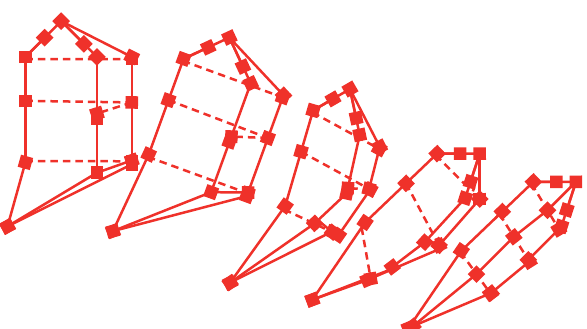
Figure 5: Interpolation example of control grid.